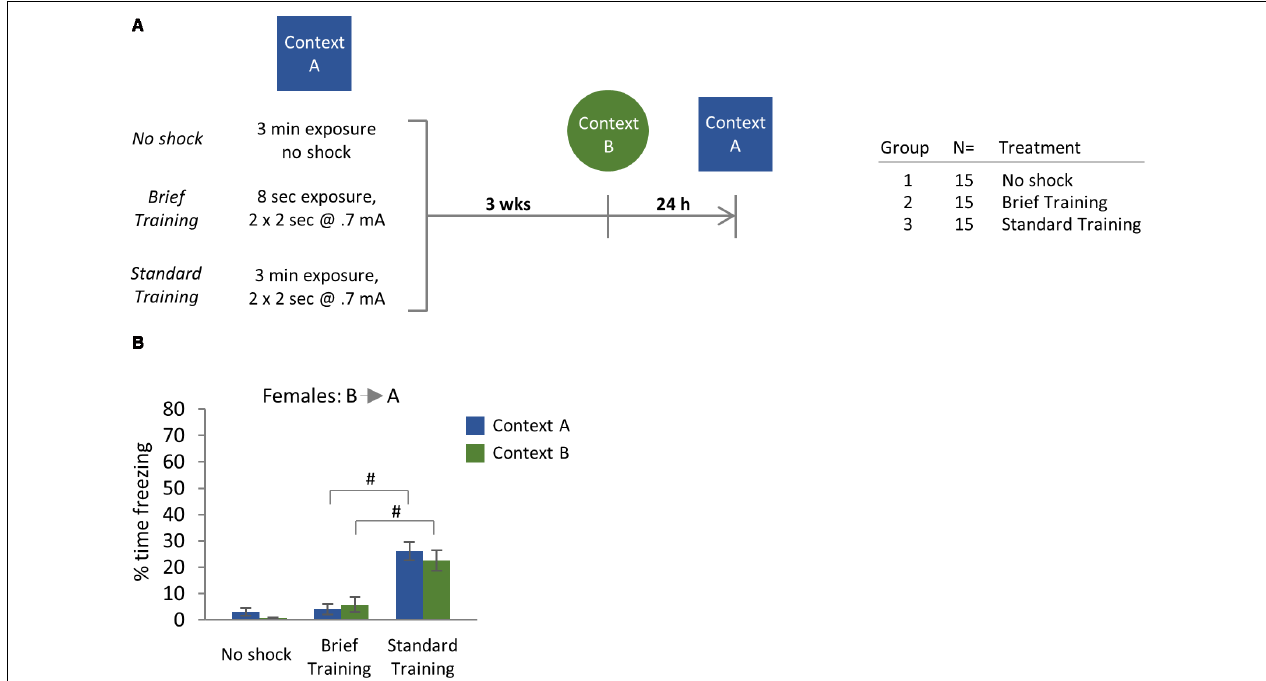
FIGURE 3 | (A) Experimental design and cohort information. (B) Effect of fear conditioning protocol (cage-exposed mice with no shock vs. brief training protocol vs. standard CFC) in female mice (B → A test order) at 3 weeks after initial training. Significant Tukey post hoc comparisons following two-way ANOVA are indicated. # p < 0.0001. Error bars are mean ±